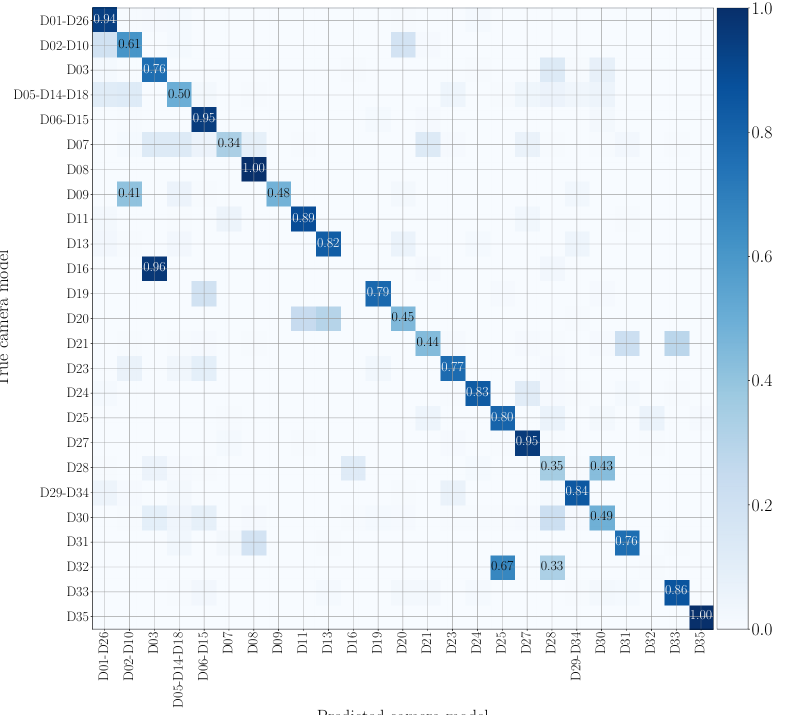
Figure 10. Confusion matrix achieved by mono-modal camera model identification, exploiting audio patches only. We report results by training on the native video set and testing on the YouTube set, and we only show the numbers which exceed 0.3. The device nomenclature is that of